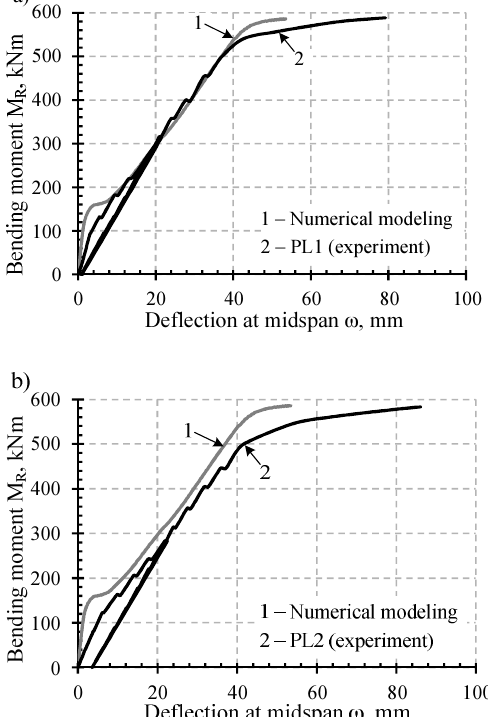
Fig. 15. Charts of the bending moment and deflection: a) slab P1; b) slab P2. 1 – curve of numerical modelling,